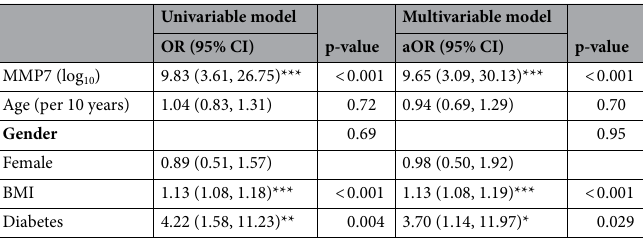
Table 2. Serum MMP7 is independently associated with clinically significant fibrosis (LSM ≥ 8.2 kPa). Logistic regression. *p < 0.05 **p < 0.01 ***p < 0.001.